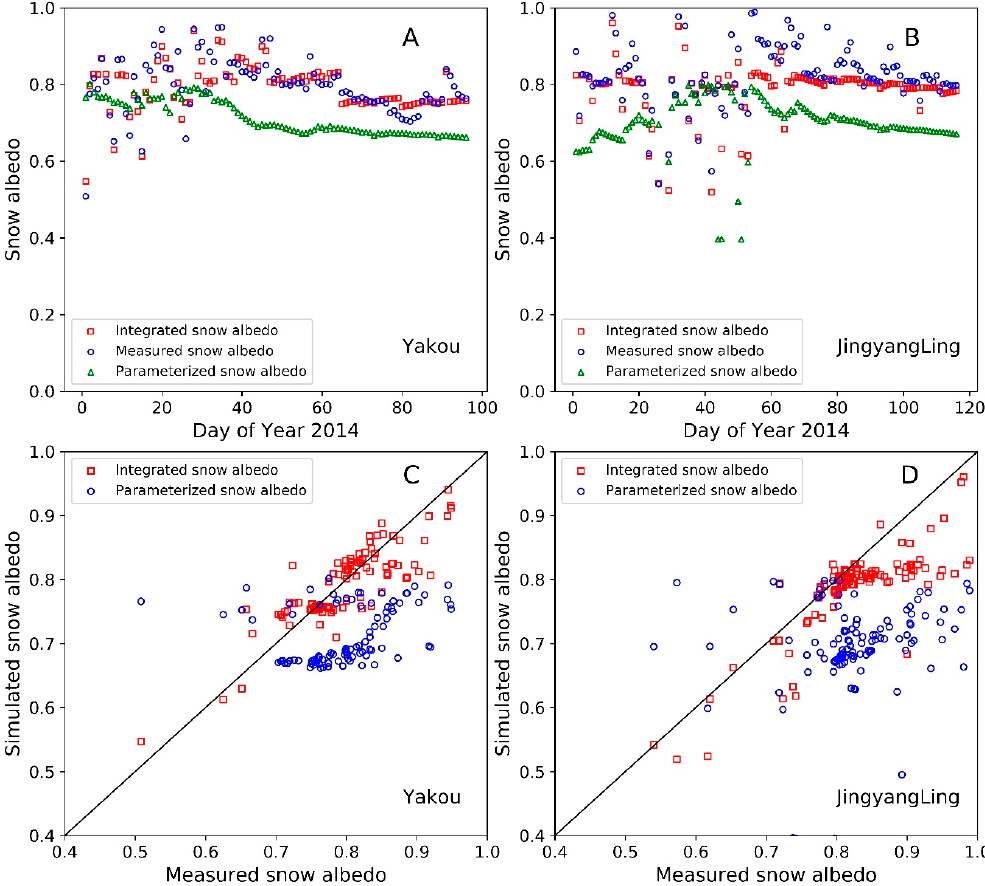
Figure 5. Evaluating the simulation accuracy of the parameterized scheme and the integrated model scheme. ( A ) Yakou station and ( B ) Jingyangling station simulation trend verification of the time series. ( C ) Yakou station and ( D ) Jingyangling station simulation accuracy verification. Table 2. Various error verification functions (including mean absolute error MAE, root mean